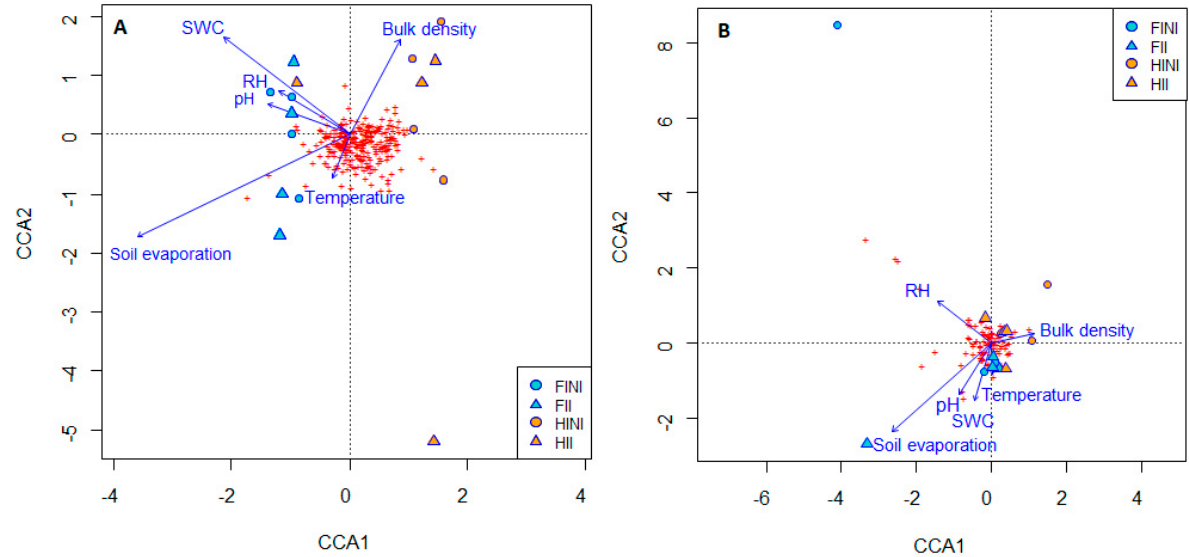
Figure 4. Canonical correspondence analysis (CCA) showing the correlation between soil edaphic factors and bacterial ( A ) and fungal ( B ) communities from vineyard soils subjected to different irrigation amounts (FI, Full Irrigated or HI, Half Irrigated), AMF inoculation (I, inoculated; or NI, non-inoculated) and their combinations.